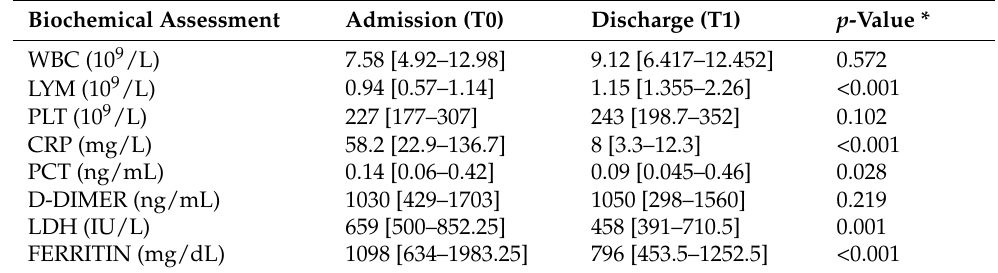
Table 4. Biochemical and hormonal assessment between admission (T0) and discharge (T1). Biochemical